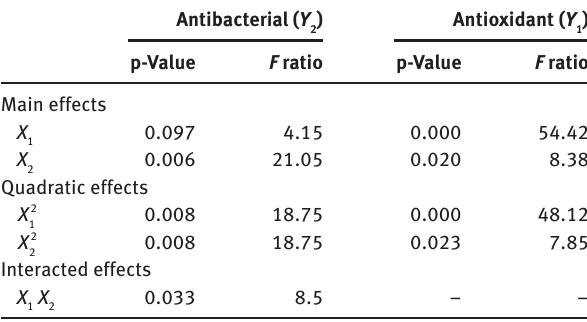
Table 3: p-Value and F ratio of the regression coefficients in the obtained models.